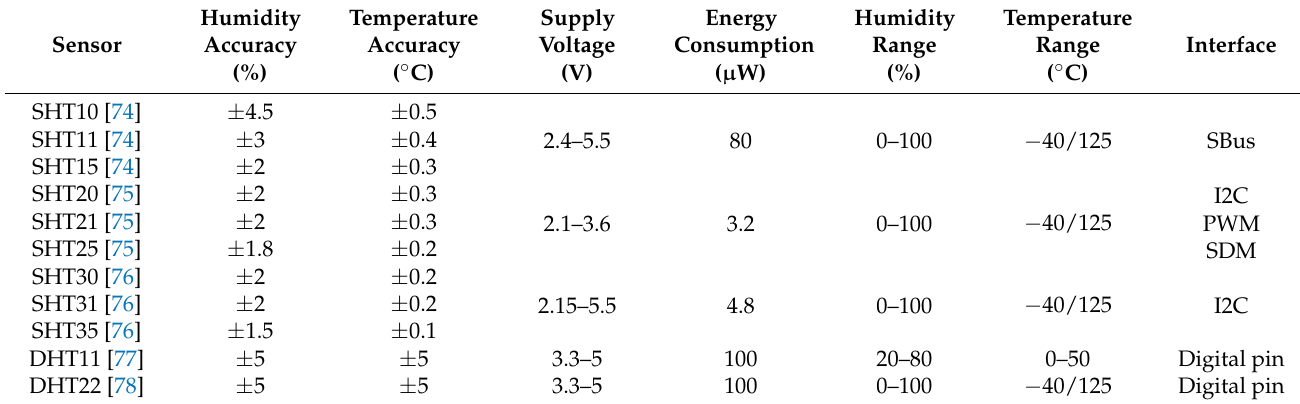
Table 5. Comparison of temperature and humidity sensors.